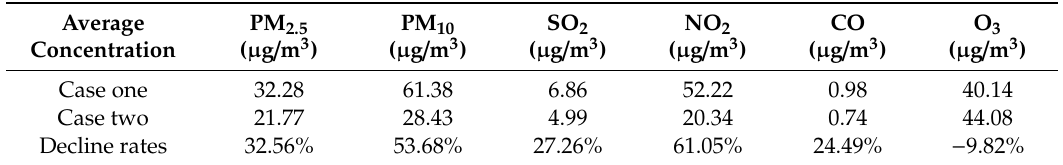
Table 3. Average concentration of six representative pollutants in two cases and their decline rates of average concentration in case